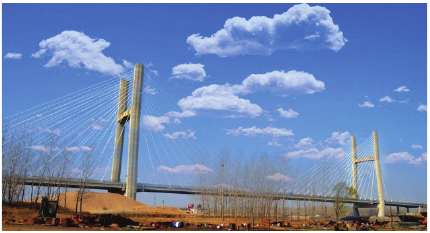
Figure 4: Guanhe Bridge panorama